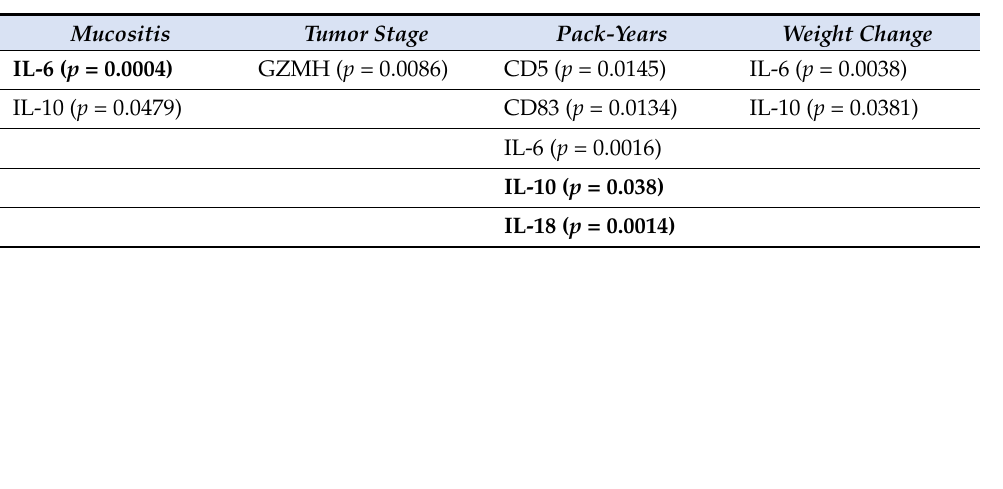
Figure 1. The longitudinal changes of 14 inflammatory proteins presented for each treatment group. Proteins exhibiting significant differences between treatment groups at the three follow-up time points are indicated, * denotes that there were statistically significant differences between the treatment groups. Table 2. Correlation between differences in protein expression and mucositis, tumor stage, smoking pack-years, and weight change, according to multivariate analysis. Proteins in bold indicate stronger correlation with the variable than the